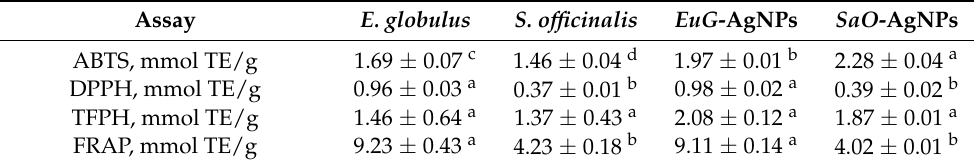
Table 2. Antioxidant activity of plant extracts and biosynthesized AgNPs ( p > 0.05).